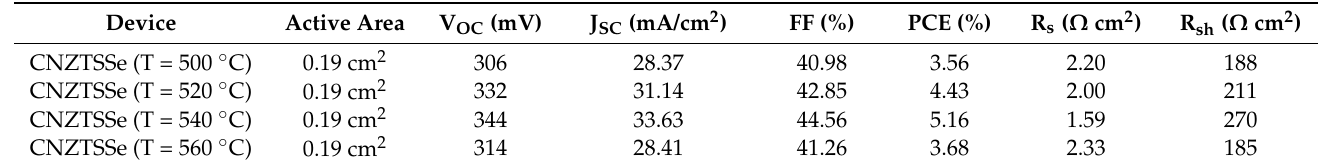
Table 3. Performance parameters of devices selenized at various selenization temperatures.